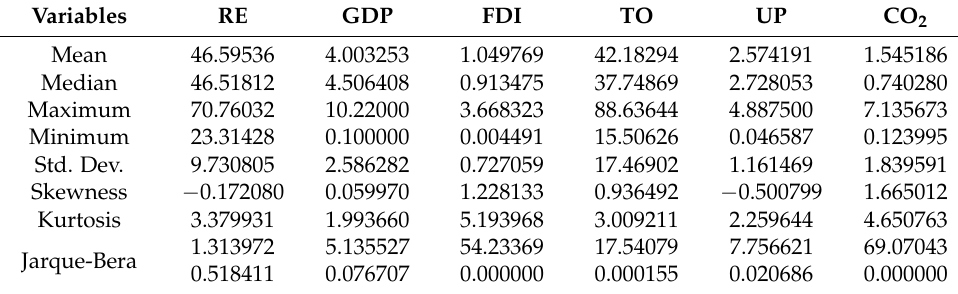
Table 2. Descriptive